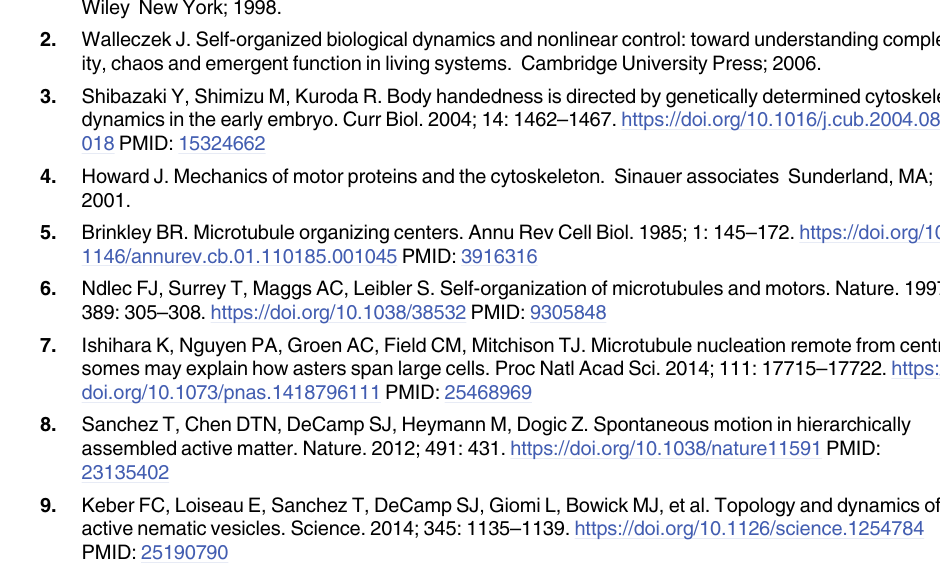
S3 Fig. Two-dimensional scattering salt crystals from dried droplet of buffer solution. (A) Two-dimensional scattering from the droplet of buffer solution and (B) profile of scattering curve. The peak corresponds to the background coming from the sample holder. The volume of buffer solution (80 mM PIPES, 1 mM EGTA, 1 mM MgCl droplet.